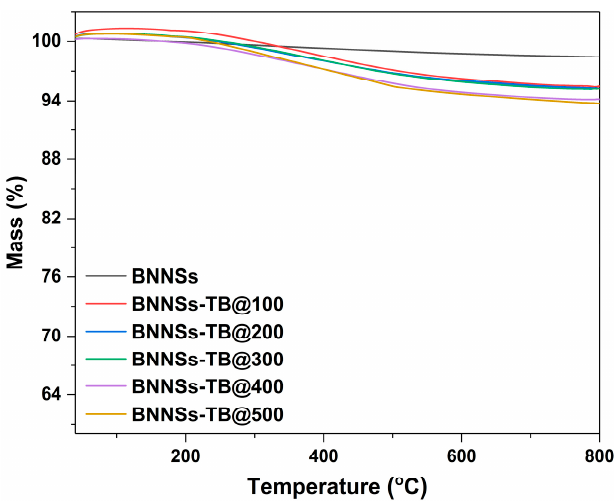
Figure 4. TG curves of BNNSs-TB with di ff erent doses.